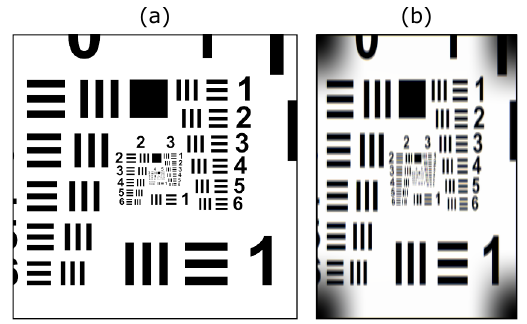
Figure 3. Image simulation of the system using 1951 USAF reso- lution test chart : (a) imaged field of view for the given distances used as the source image and (b) the result of the image simula- tion exhibiting compression along the x-axis. Anamorphic data as given in the